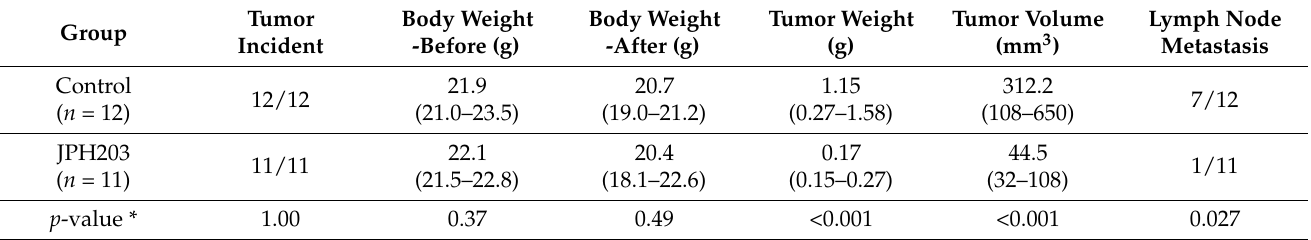
Table 2. Results of animal experiments (orthotopic implanted